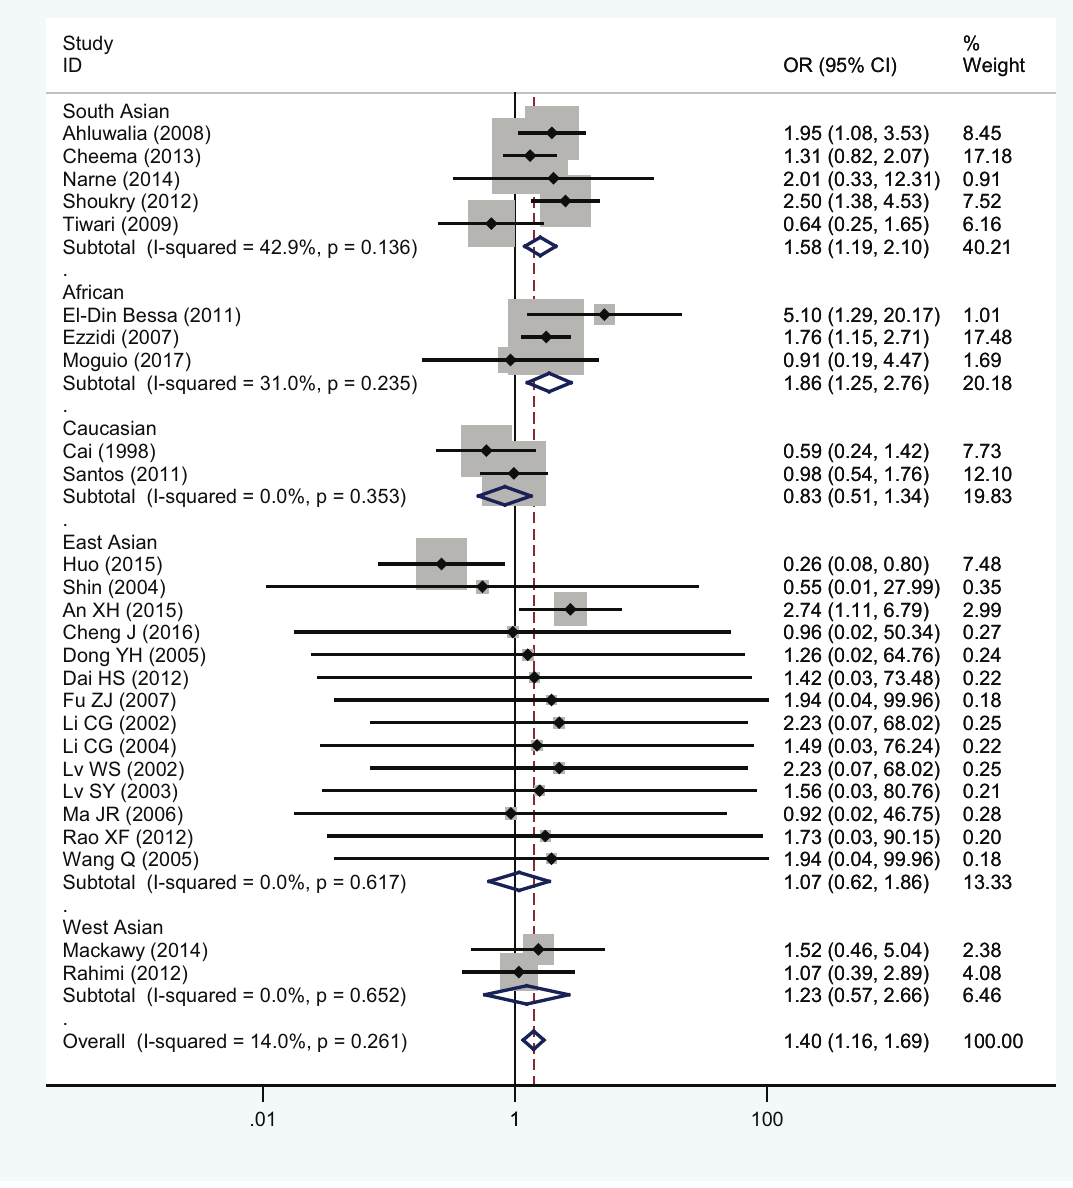
TT allele had increased risk of susceptibility to DN com - pared with GG allele ( OR = 1.40, 95% con fi dence interval ( CI ) : 1.16 – 1.69, p = 0.001 ) , Figure 2.